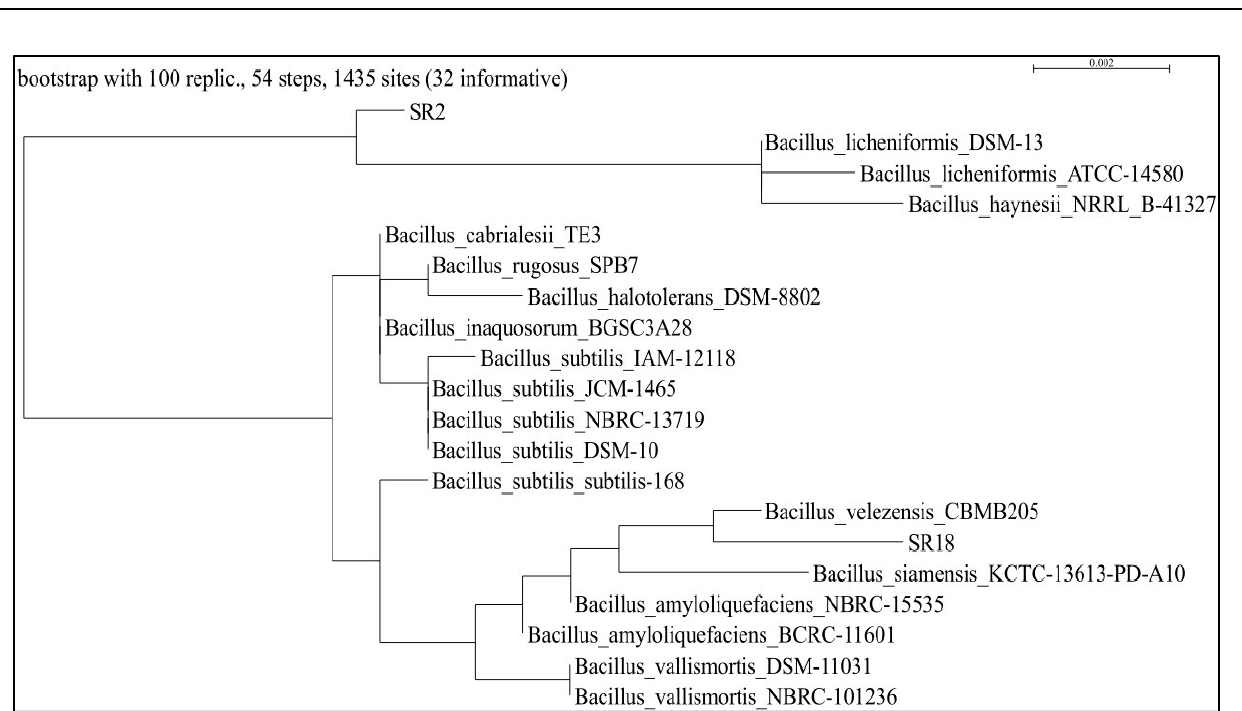
Figure 1. Phylogenetic tree analysis of multifarious PGPRs, viz., SR2 Bacillus licheniformis and SR18 Bacillus velezensis . This was conducted on the basis of 16SrRNA gene sequence alignment obtained from the rhizosphere of rice plants grown in the vicinity of IGP regions.